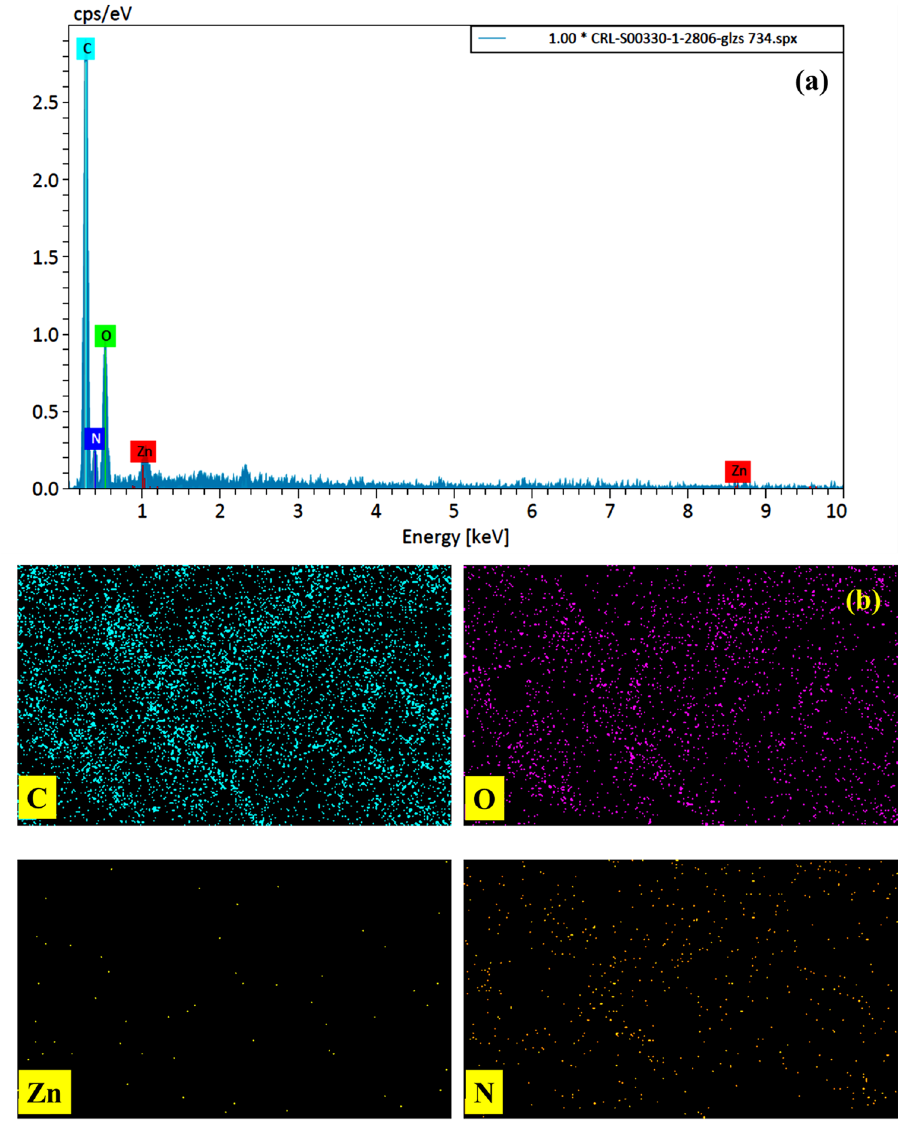
Figure 3. ( a ) EDX analysis and ( b ) element mapping of Graphene oxide-lignin/silk fibroin/ZnO